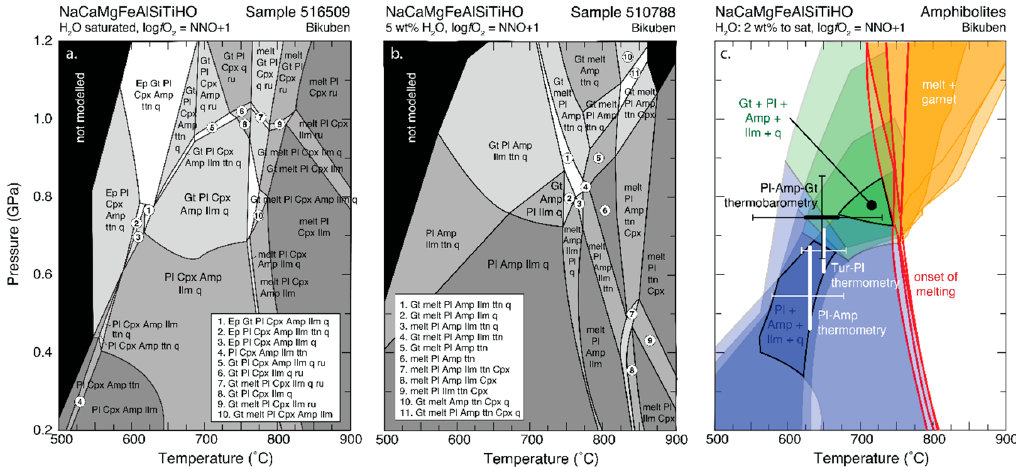
Figure 6. Pseudosection results for Bikuben assemblages; ( a,b ) Typical pseudosections for a Bikuben calc-silicate and amphibolite, respectively; ( c ) Compilation of Bikuben pseudosection results showing fields and reactions observed in these samples. Tourmaline–plagioclase and plagioclase–amphibole thermometry results agree well with the field for pl–amp–ilm–q peak parageneses in meta-basalts, and fields for garnet-bearing assemblages in meta-basalts and calc-silicates also agree well and provide a narrow field in P–T consistent with plagioclase–amphibole–garnet–clinopyroxene thermobarometry. The onset of melting and the field of coexisting garnet and melt are also shown. Minerals starting with a capital letter were modelled as a solid solution. Mineral abbreviations as in Figure 3 and cpx =